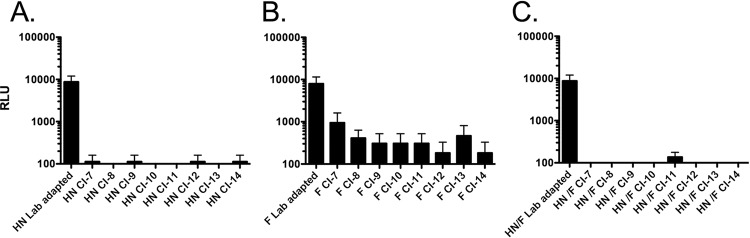
The CI-derived HN and Fs are less efficient at promoting cell-cell fusion than the proteins derived from HPIV3 virus adapted to growth in immortalized cells. (A) 293T cells coexpressing the indicated HN with the F derived from a laboratory reference strain, (B) 293T cells coexpressing the indicated F with the HN derived from a laboratory reference strain, or (C) 293T cells coexpressing the indicated HN/F pair were allowed to fuse with receptor-bearing cells at from 37°C on. Cell fusion was measured as relative light units (RLU [y axis, log scale]) in the presence of each HN/F pair (as indicated on the x axis). The bars represent means ± standard errors of the meant (SEM) from triplicate samples from a representative experiment.